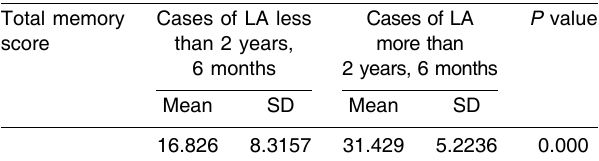
Table 4 Comparison of the mean of total memory scores between two LA categories Total memory Cases of LA less score